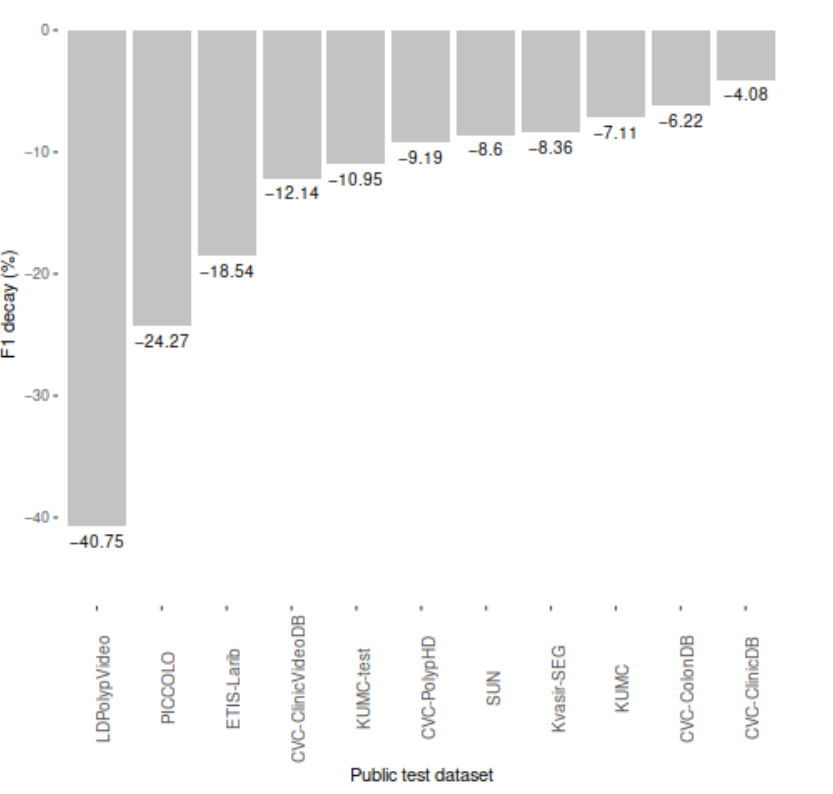
Figure 5. F1 decay (%) in public colonoscopy image datasets compared to the performance of our model in our private dataset reported in Nogueira-Rodríguez et al., 2021 (0.88) [26].